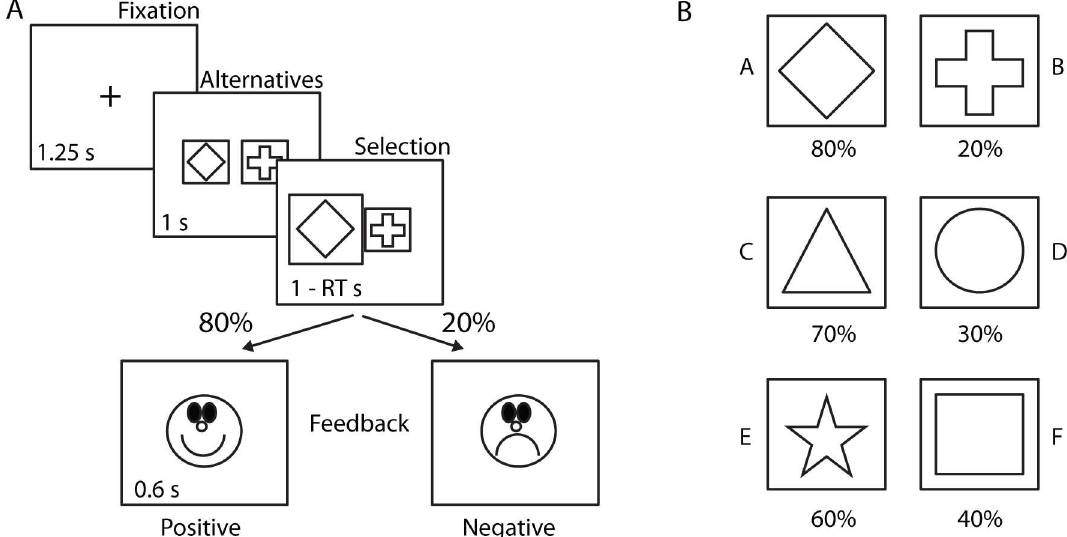
Fig 1. Probabilistic Selection Task (PST). A. One trainingtrial in the PST. After fixation, two symbols were presentedand participantsselectedone symbol within 1s. After 1s positive or negativefeedbackwas presentedbasedon the reward probabilityassociatedwith the selectedsymbol. RT = responsetime. B. Rewardprobabilities associatedwith each pair and symbol. The symbols associatedwith each rewardprobabilitywere randomized betweenparticipants.